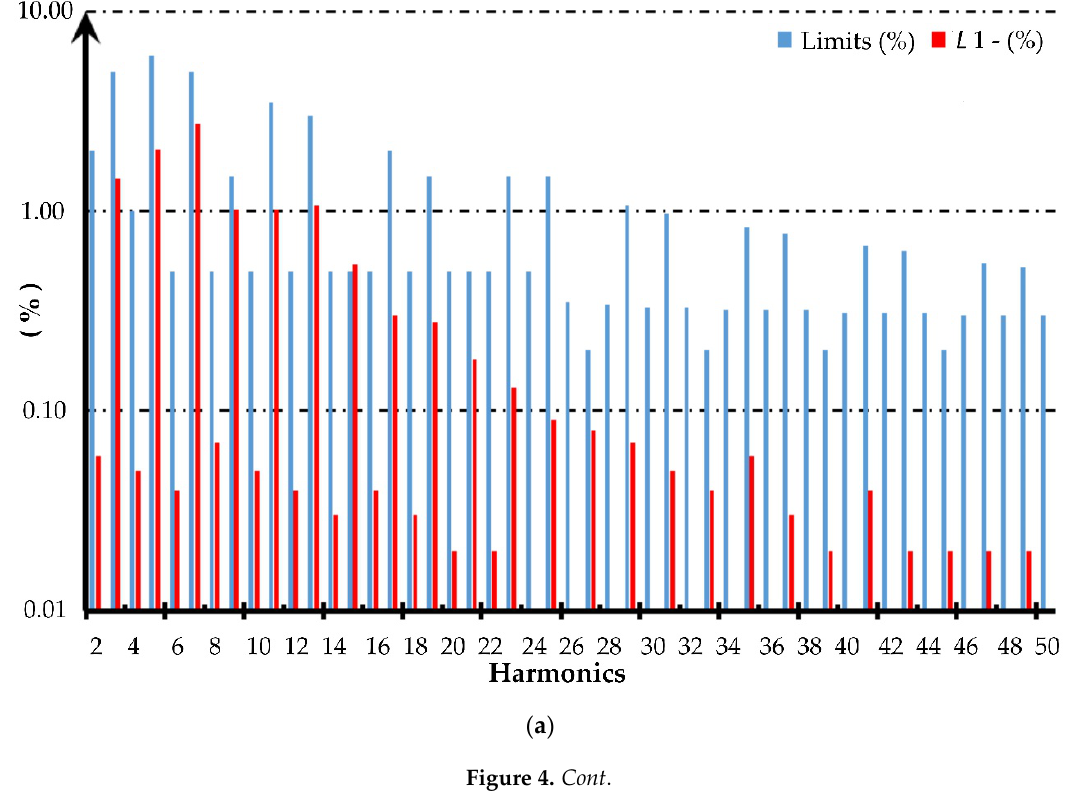
Figure 4 represents the distribution of harmonics in individual phases L 1, L 2, L 3 during the measurement period, where the x axis represents harmonics, while y axis percentage share of a given harmonics. The measured values are marked in red, the permissible limits of individual harmonics are shown in light blue.